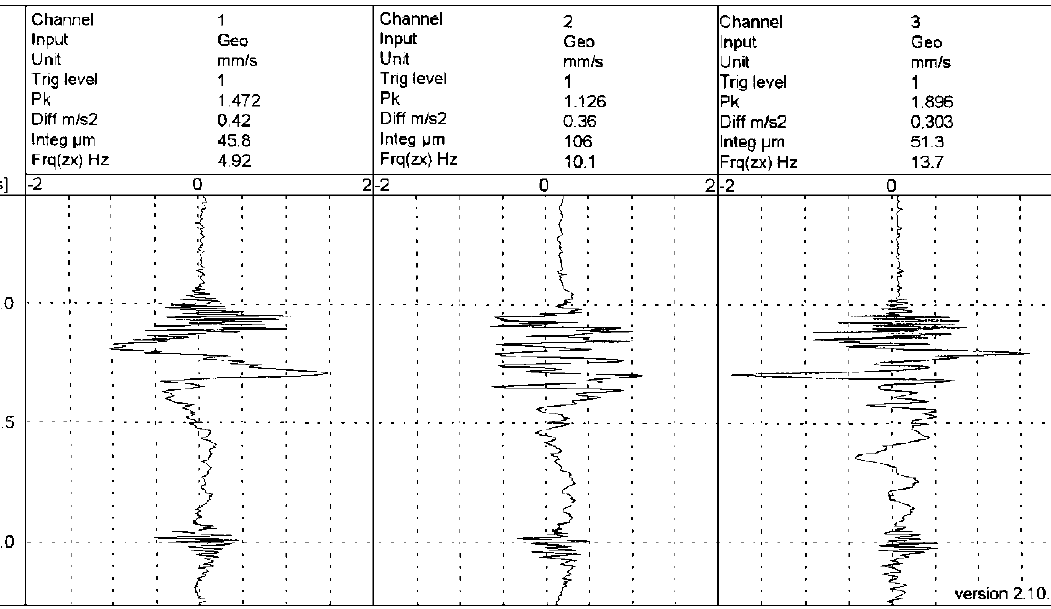
Table 4. Survey of blasting parameters and measurement results in the Kovilova č a Open Pit Pit. No.